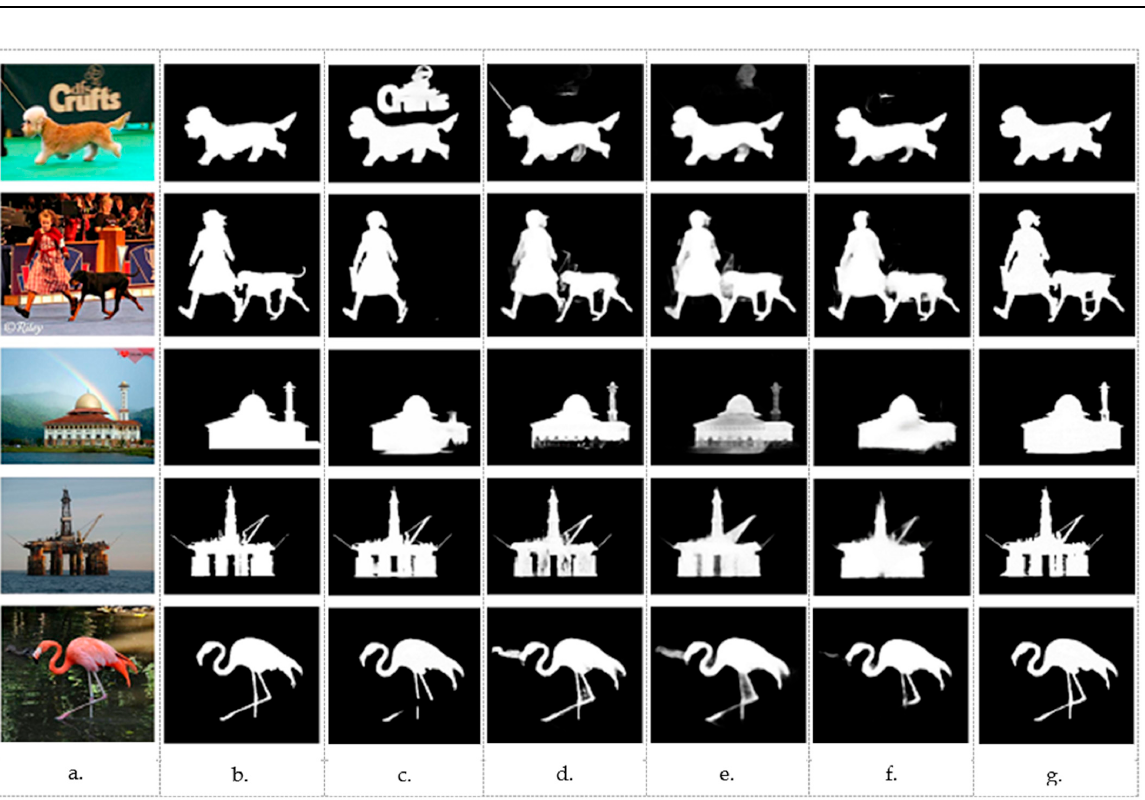
Figure 6. Qualitative comparison of the proposed method (a. Image; b, Ground Truth; c, BASNet[23]; d, AFNet[32]; e, PiCaNet[34]; f, RAS[37]; g, Proposed MEAN)